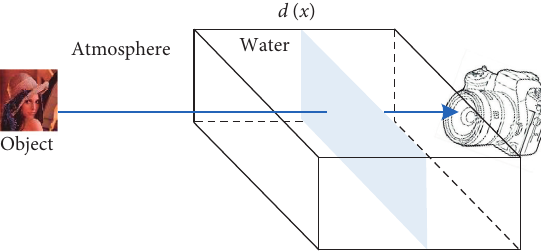
Figure 6: Mixed scattering model used to describe both media underwater and atmosphere. The path of light propagation is from the object to the camera, shown with the blue line. The tank is filled with water and